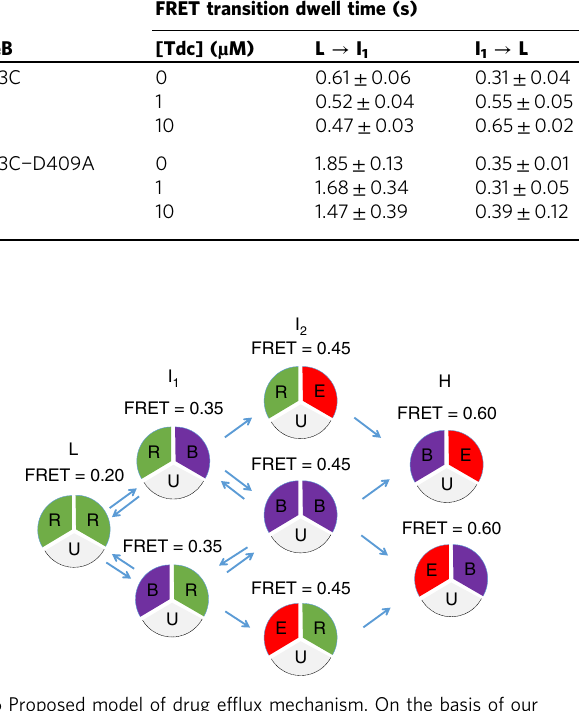
Table 2 Dwell times for CmeB transitions FRET transition dwell time (s)